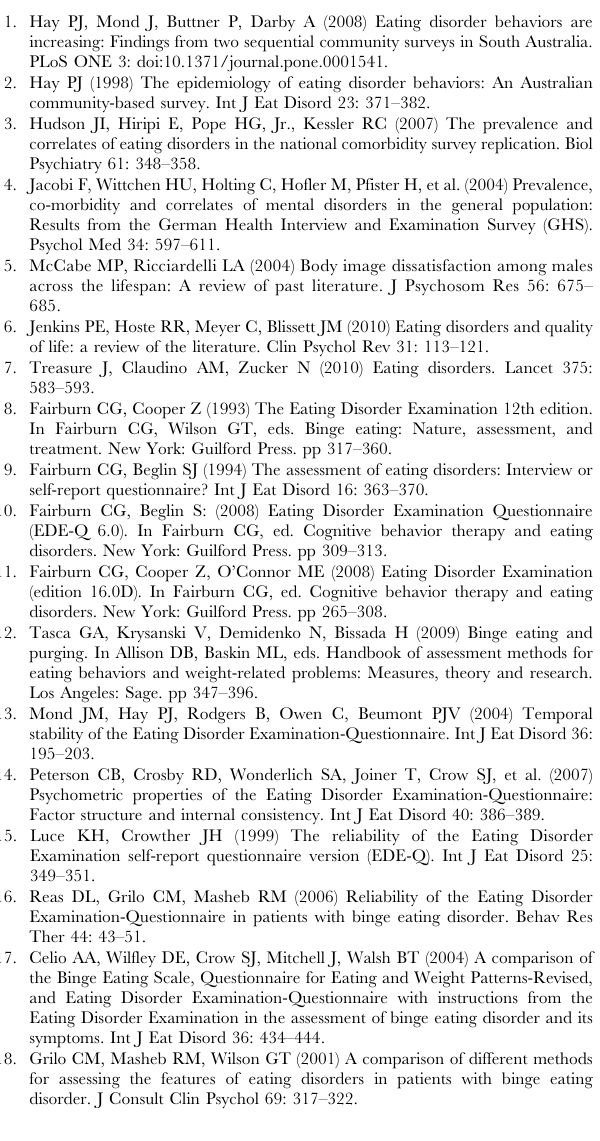
Table S2 Distribution of Eating Disturbances as Determined by the Eating Disorder Examination-Questionnaire Global Score